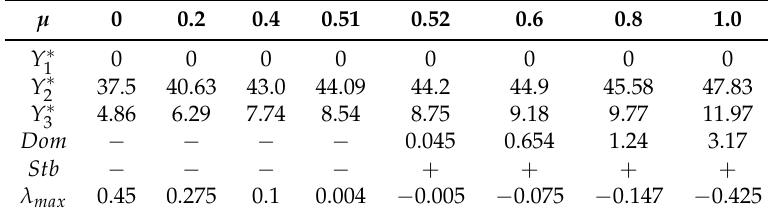
Figure 2. Full profitability states. Table 3. The ( 23 ) -profitability states.